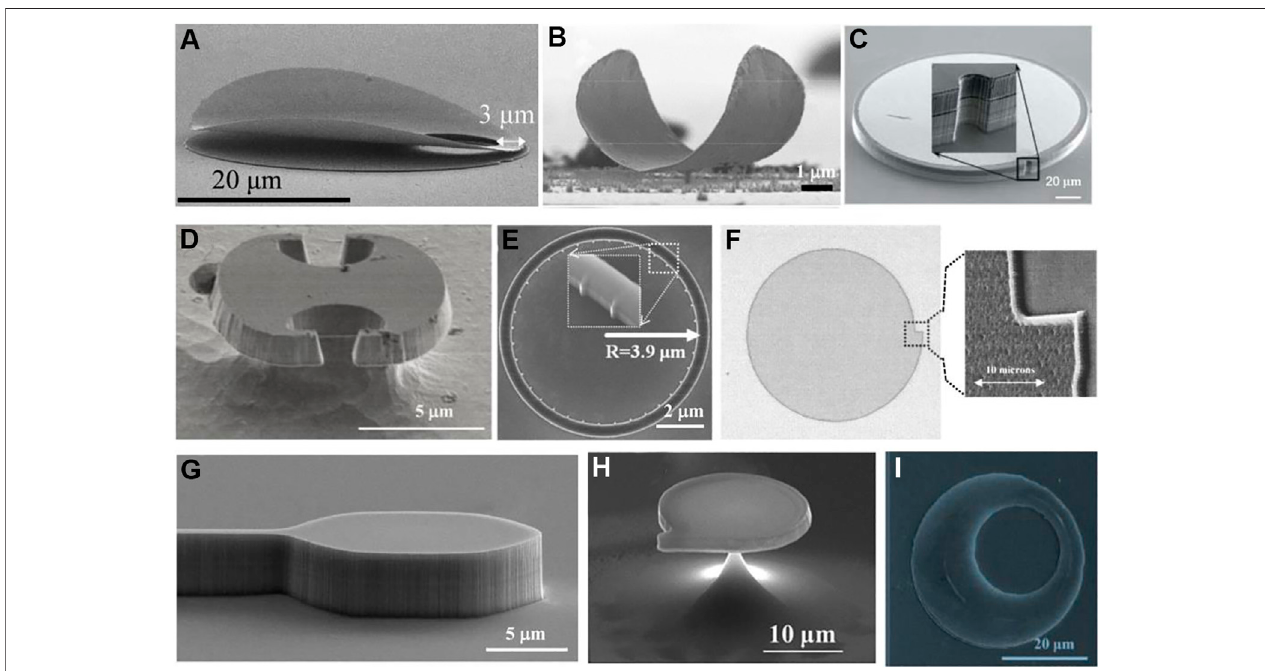
FIGURE 5 | (A,B) Microring with an off-centered embedded hole and warped structure (Li et al., 2018; Zhang et al., 2021). (C) Notched elliptical microcavity quantum cascade lasers (Wang et al., 2010). (D) Microdisk with a self-focusing structure (Zhu et al., 2019). (E) Microdisk with grating structures (Cai et al., 2012). (F) Spiral microcolumn cavity (Ben-Messaoud and Zyss, 2005). (G) Circular-side hexagonal resonator (CSHR) microlasers (Xiao et al., 2017). (H) Microdisk with a corner (Zhu et al., 2017). (I) Microdisk with a hole (Zhang et al., 2020). Reprinted with permission © PNAS Publishing (Wang et al., 2010), © IOP Publishing (Zhu et al., 2019), © American Association for the Advancement of Science (Cai et al., 2012), © AIP Publishing (Ben-Messaoud and Zyss, 2005; Zhu et al., 2018), © OSA Publishing (Xiao et al., 2017; Zhang et al.,